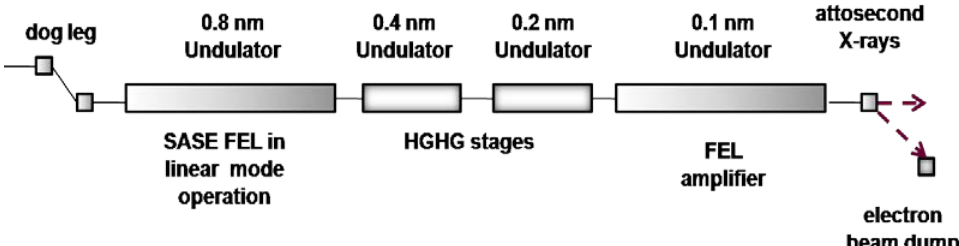
Figure 1. (Color online). High gain harmonic generation (HGHG) attosecond free electron laser (FEL). Ultrafast X-ray pulses are produced through a sequence of undulators, which are resonant at different wavelengths